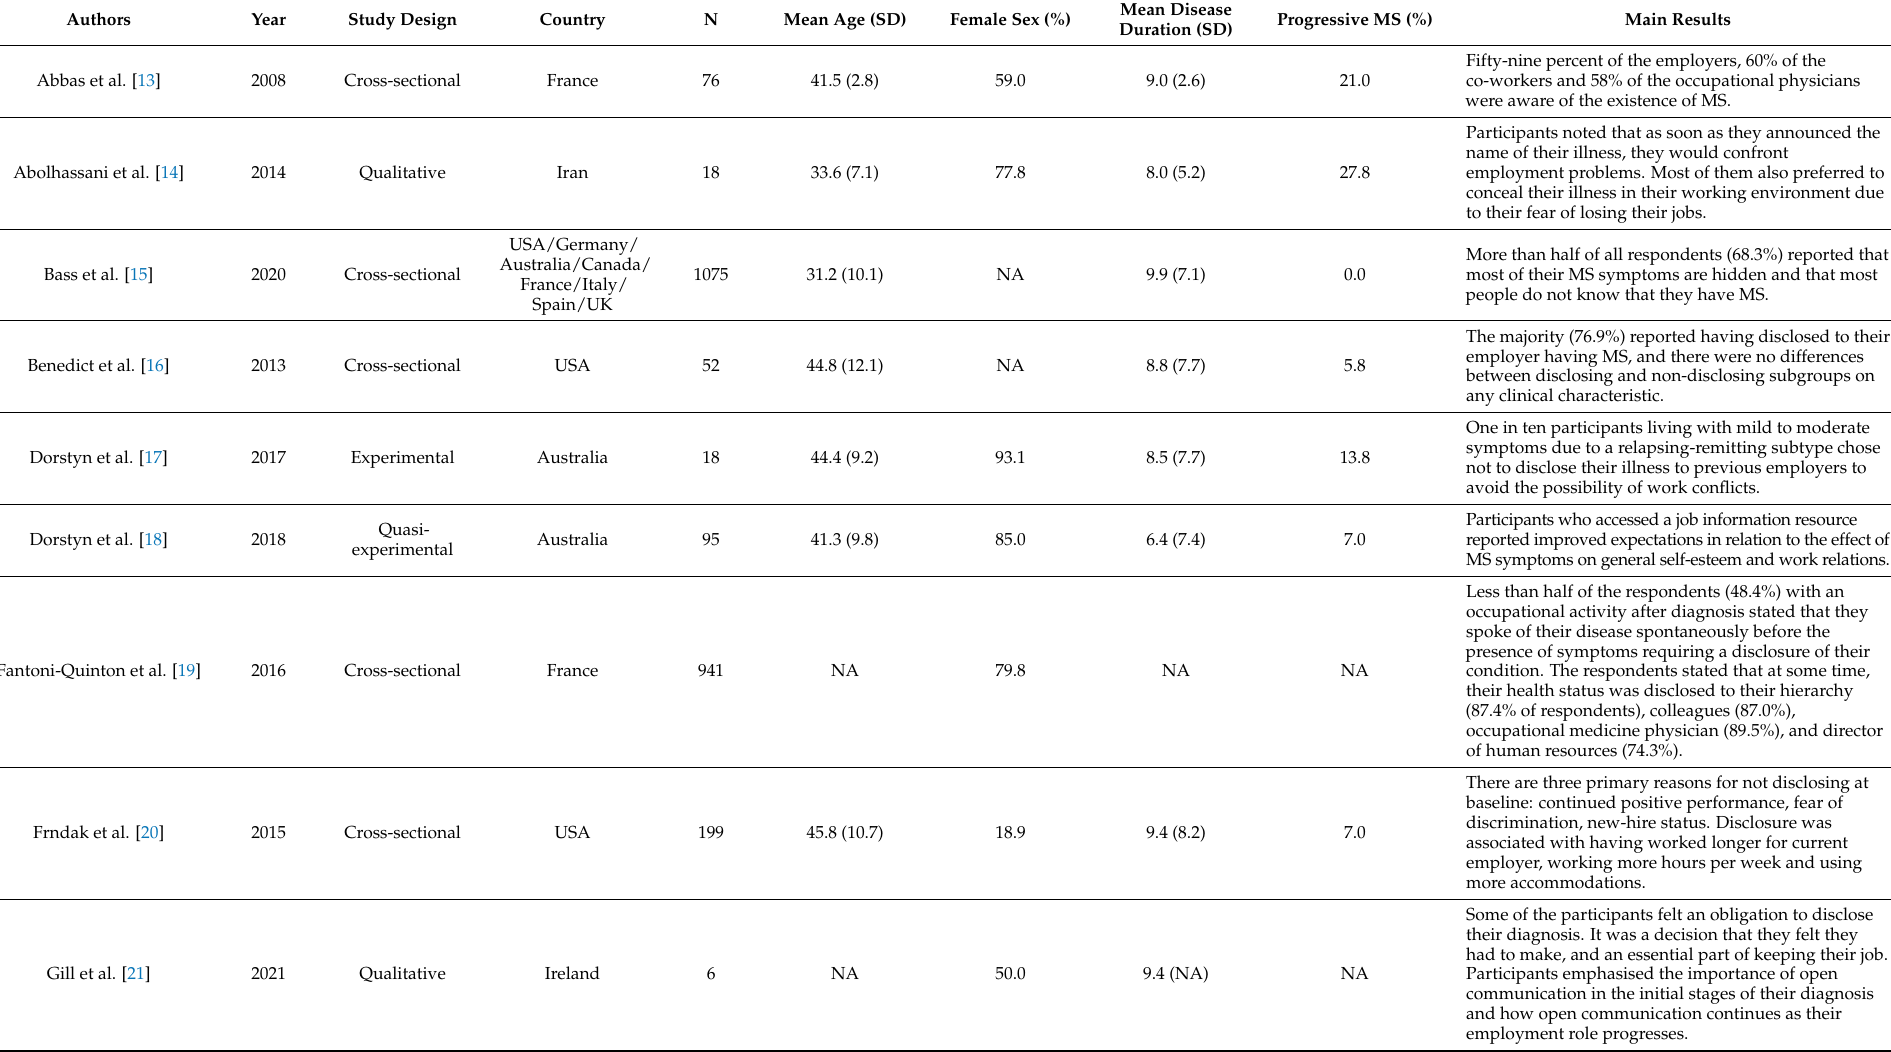
Table 2. Description of the main characteristics of the studies included in the systematic